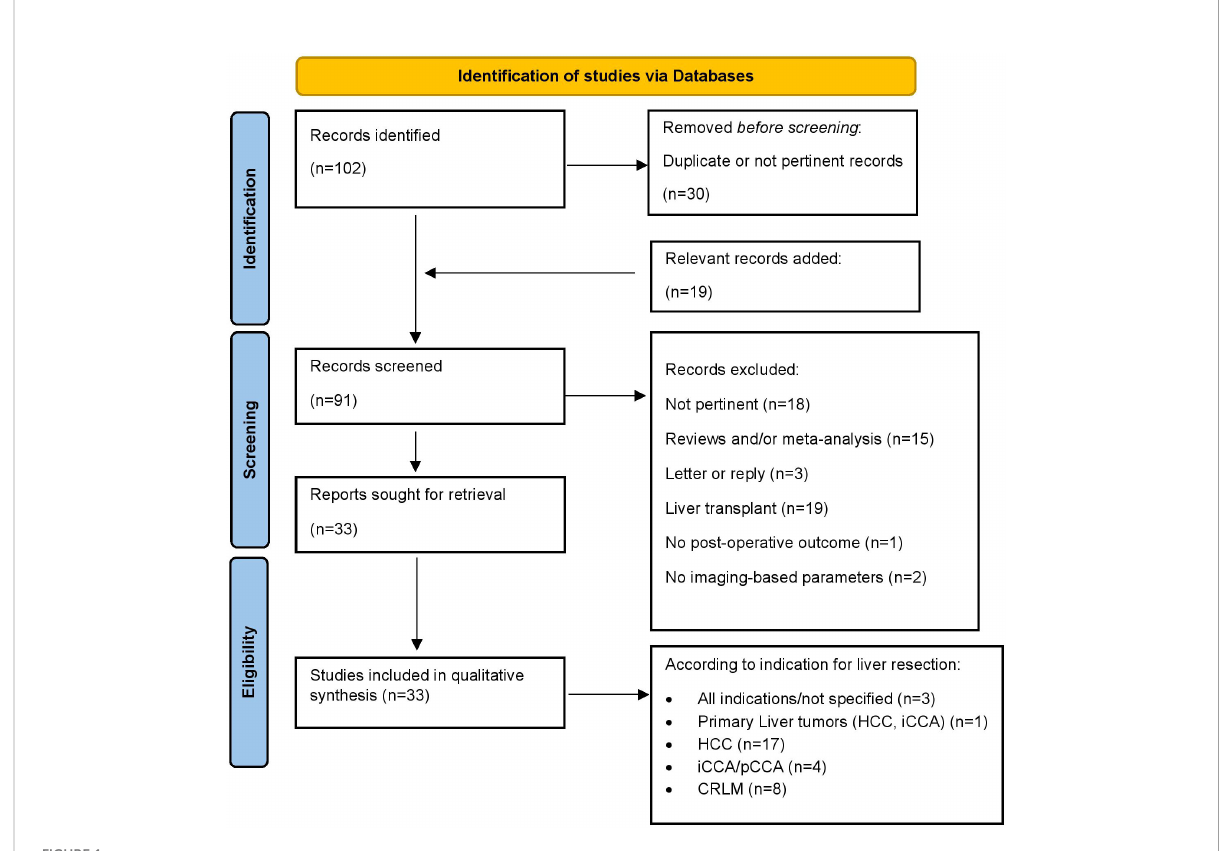
FIGURE 1 Identi fi cation of studies via